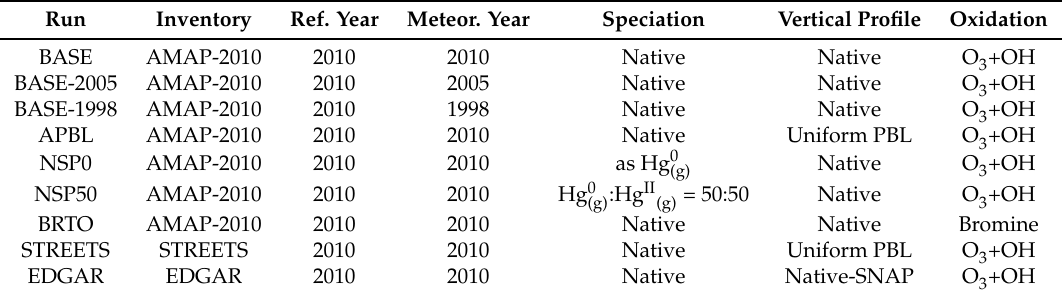
deposition in each receptor region. anthr